Question: State the chart type depicted above.
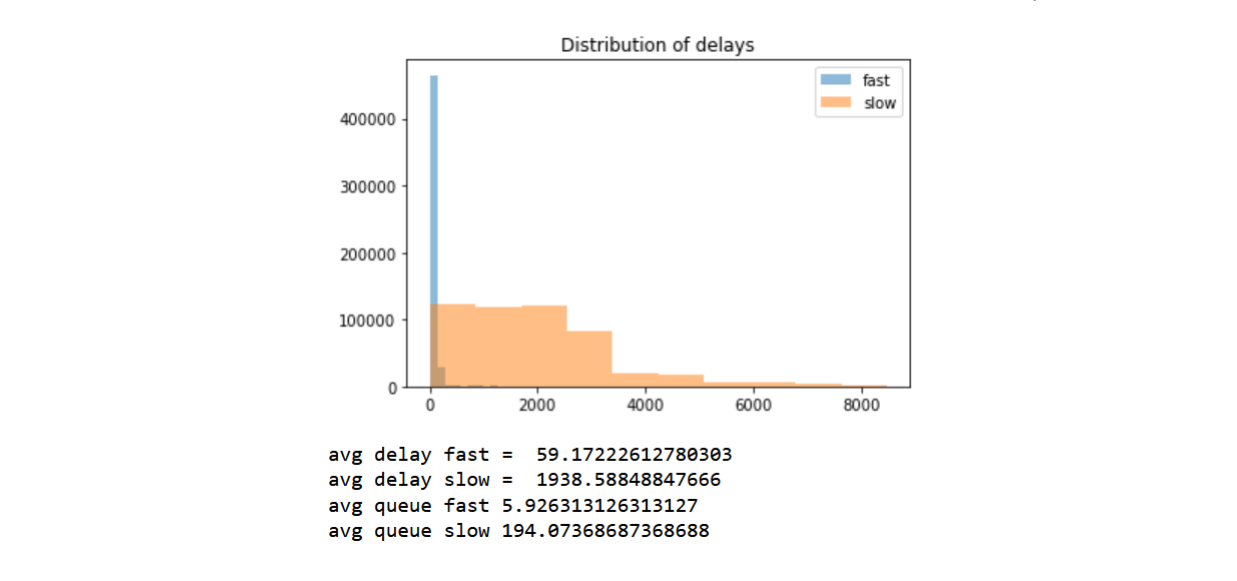
Answer: histogram